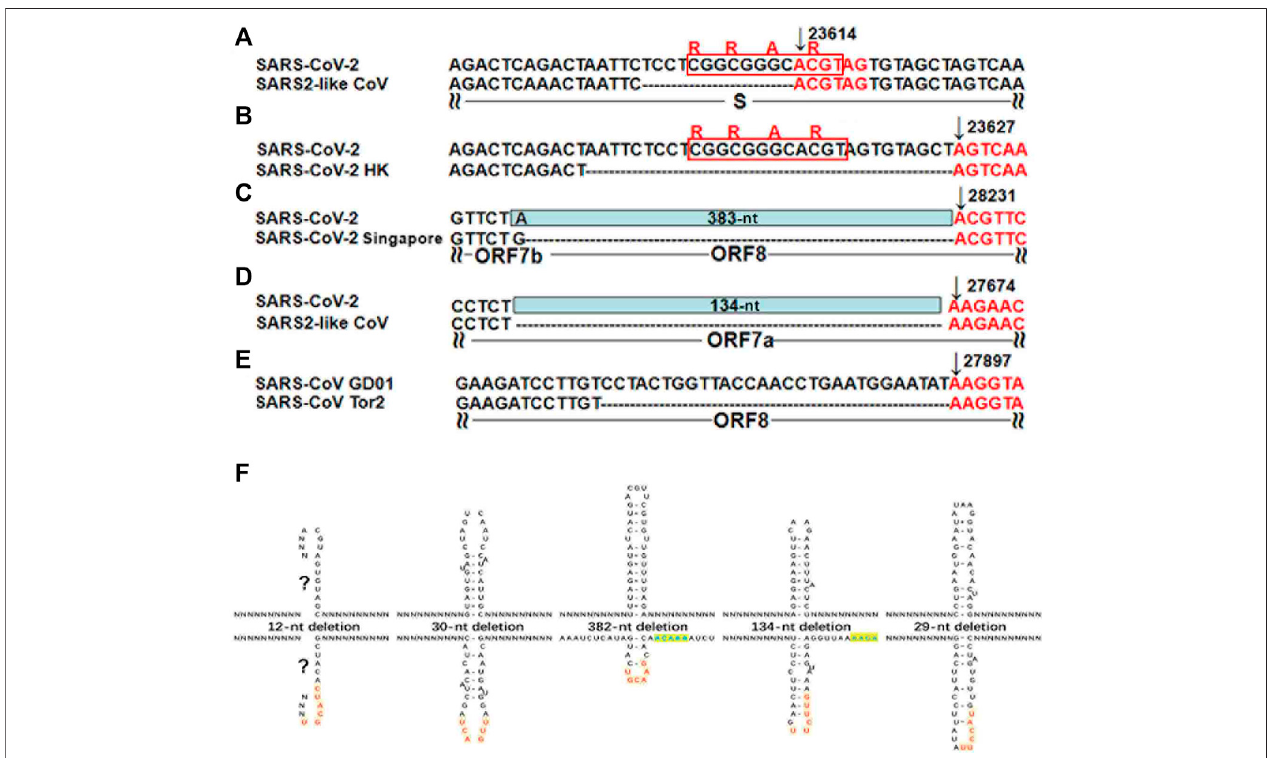
FIGURE 3 | TRS hairpins in fi ve recombination regions. (A-E) have already been published in our previous study (Li et al., 2021a). N represents any nt. All the positions were annotated on the SARS-CoV (GenBank: AY278489) or SARS-CoV-2 (GenBank: MN908947) genomes. (A) . The genome (GenBank: MN996532) of the SARS2-like CoV strain RaTG13 from bats is used to show the 12-nt deletion; (B) . The genome (GISAID: EPI_ISL_417443) of the SARS-CoV-2 strain Hongkong is used toshowthe30-ntdeletion; (C) .Thegenomes(GISAID:EPI_ISL_414378,EPI_ISL_414379andEPI_ISL_414380) ofthreeSARS-CoV-2strainsfromSingaporeare used to show the 382-nt deletion; (D) . The genome (GenBank: MT457390) of the mink SARS2-like CoV strain is used to show the 134-nt deletion; (E) . The genome (GenBank: AY274119) of the SARS-CoV strain Tor2 is used to show the 29-nt deletion . (F) . These recombinant events occurred at the non-canonical NSP15 breakpoints that also end with at least an uridine residue ( “ U ” ), due to the cleavage of the non-canonical TRS